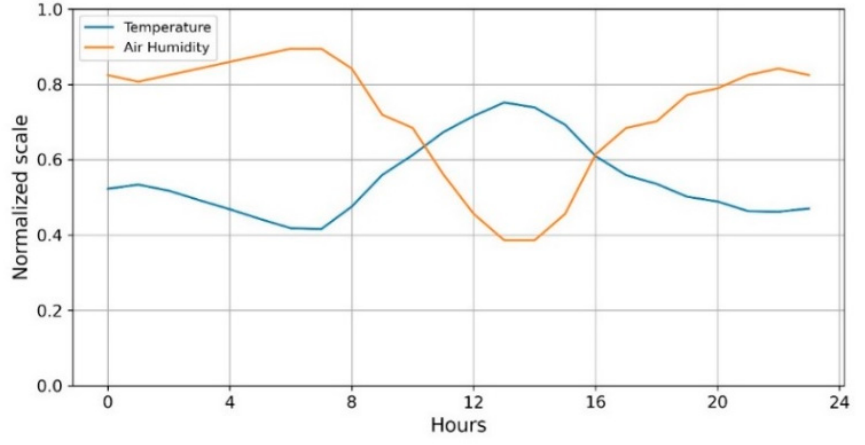
Figure 6. Temperature and air humidity in 24 h.